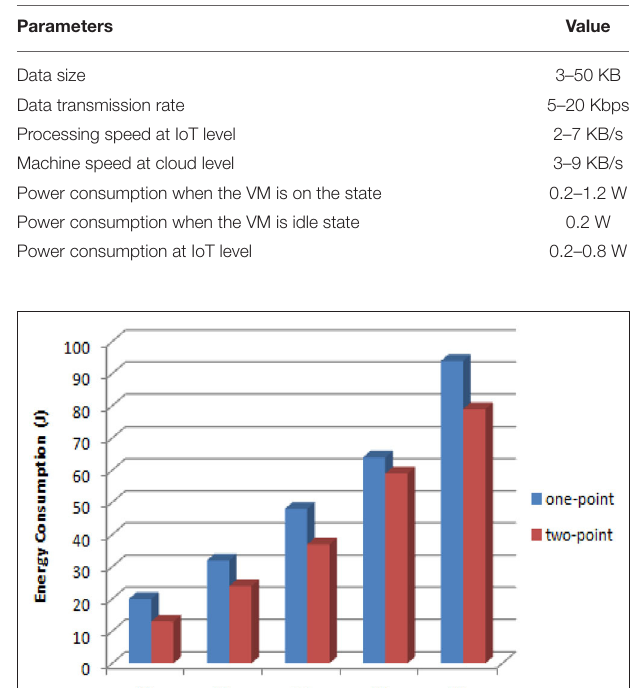
Algorithm 1 | Energy Optimization in Cloud IoT by using GA.